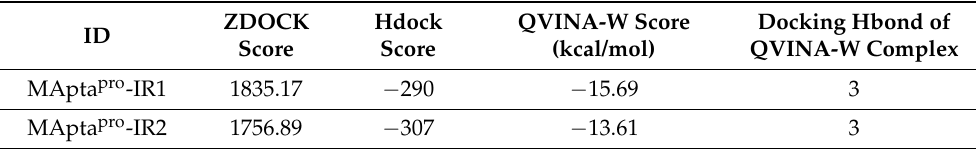
Table 2. Docking score of the best against M pro aptamer structures generated with inverseRNA